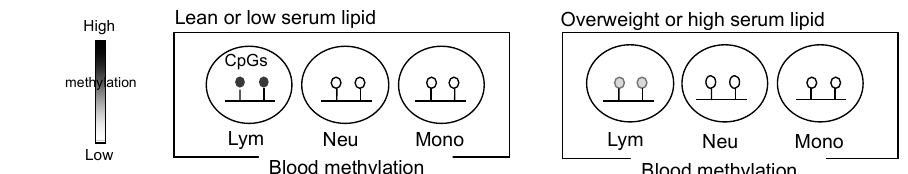
Figure 6. Scatter plots showing the relationship between pre-pregnancy BMI and CPT1A intron1 methylation. Solid line, a regression line; dotted line, 95% confidence intervals. The scale is adjusted to the methylation for each CpG site. β (regression coefficient) stands for the % change in methylation per unit increase (1 kg/m 2 ) in BMI.